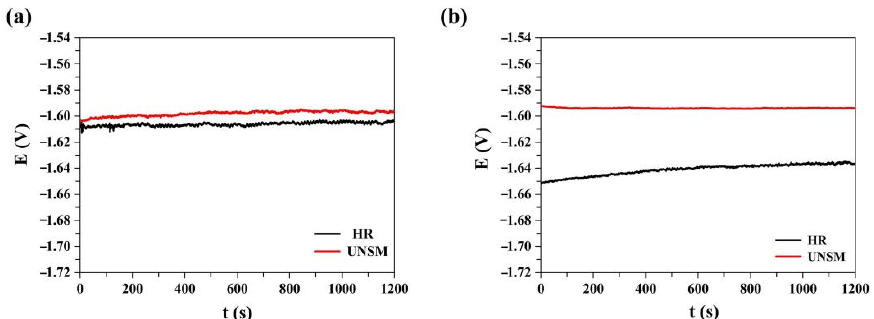
Figure 10. The open circuit curves of LAE361 Mg-Li alloy ( a ) and LA106 Mg-Li alloy ( b ) before and after the UNSM treatment in 3.5 wt.% NaCl solution at RT.